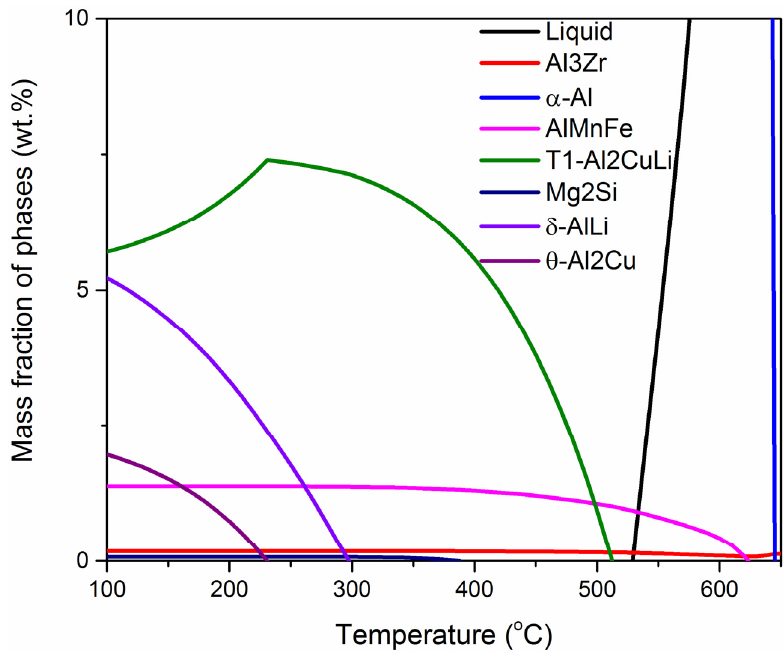
Figure 2. The equilibrium phase diagram of 2A97 (local amplification).